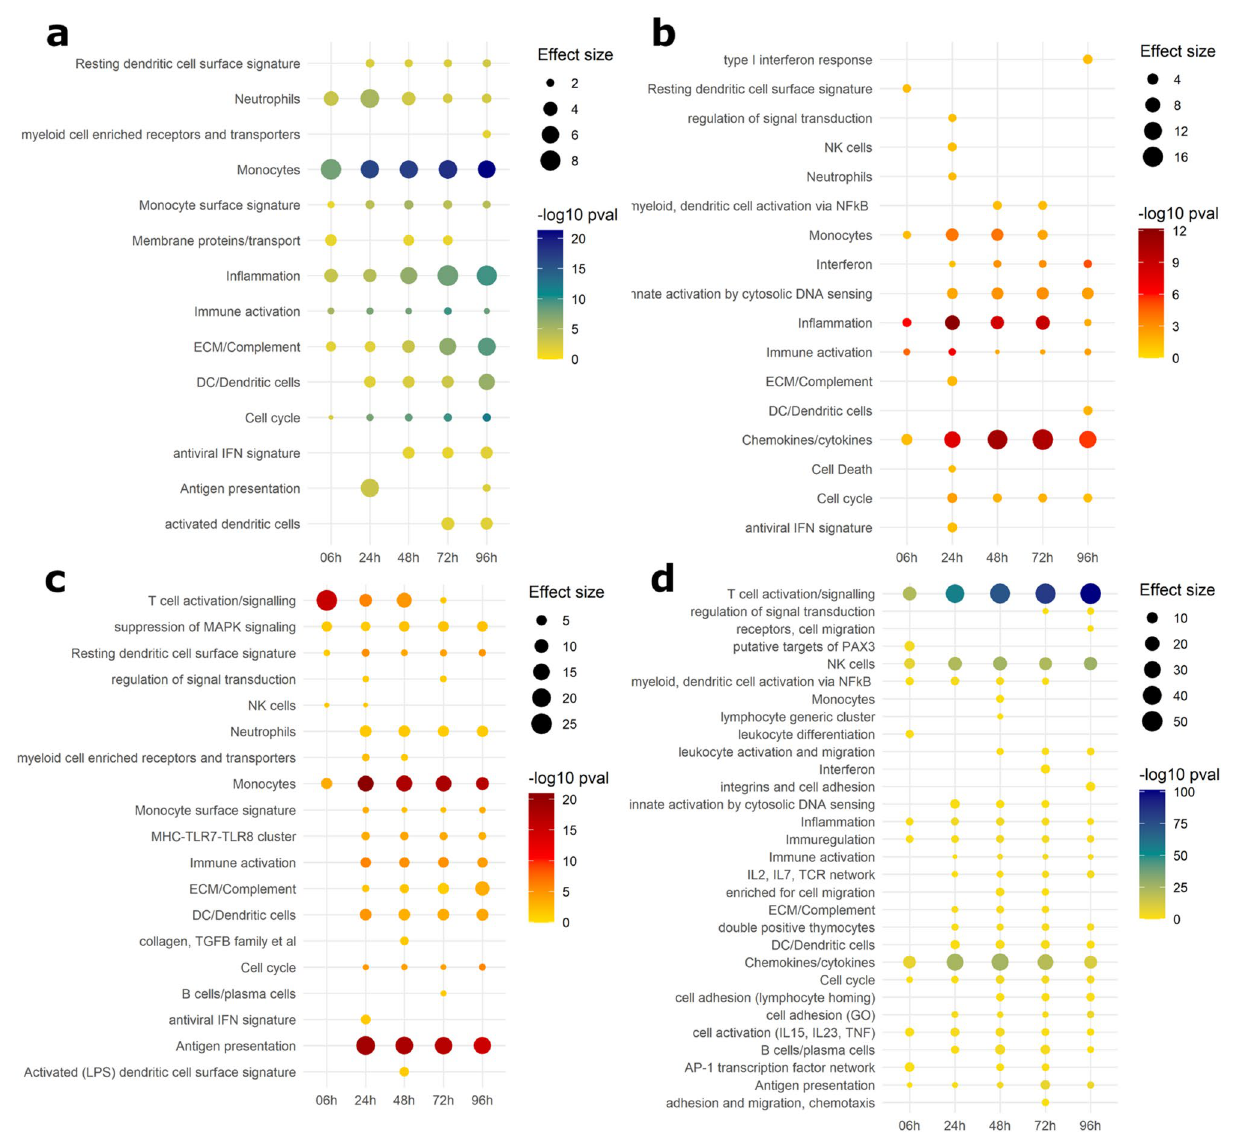
Figure 5. Dotplot of gene modules identified in paediatric in vivo–in vitro comparison. Gene Set Enrichment Analysis (GSEA) was performed on transcripts from the disco plot quadrants. Similar modules were summarised and plotted such that p-value of module enrichment is illustrated by the intensity of the colour and the effect size by the size of the dot. ( a ) Gene modules upregulated in vivo and downregulated in vitro. ( b ) Concordantly upregulated gene modules. ( c ) Concordantly downregulated gene modules. ( d ) Gene modules downregulated in vivo and upregulated in cES = 2.98, average p val = 4.6 × 10 −4 ). T cell and B cell modules were strongly concordantly downregulated in the comparisons with 6–24 h in vitro (cES = 14.5, p val = 6.1 × 10 −13 and cES = 17.95, p val = 5.09 × 10 −18 respectively) in is sevenfold lower than T cell modules. Modules that are upregulated in vitro and downregulated in vivo (Fig. 4d, representing quadrant IV) show most apparent discordance in T cell and B cell modules, which increases cES = 2.13, p val = 0.025, at 96 h: cES = 23.5, p val = 8.56 × 10 −39 ). NK cells also have a slight time signature, with